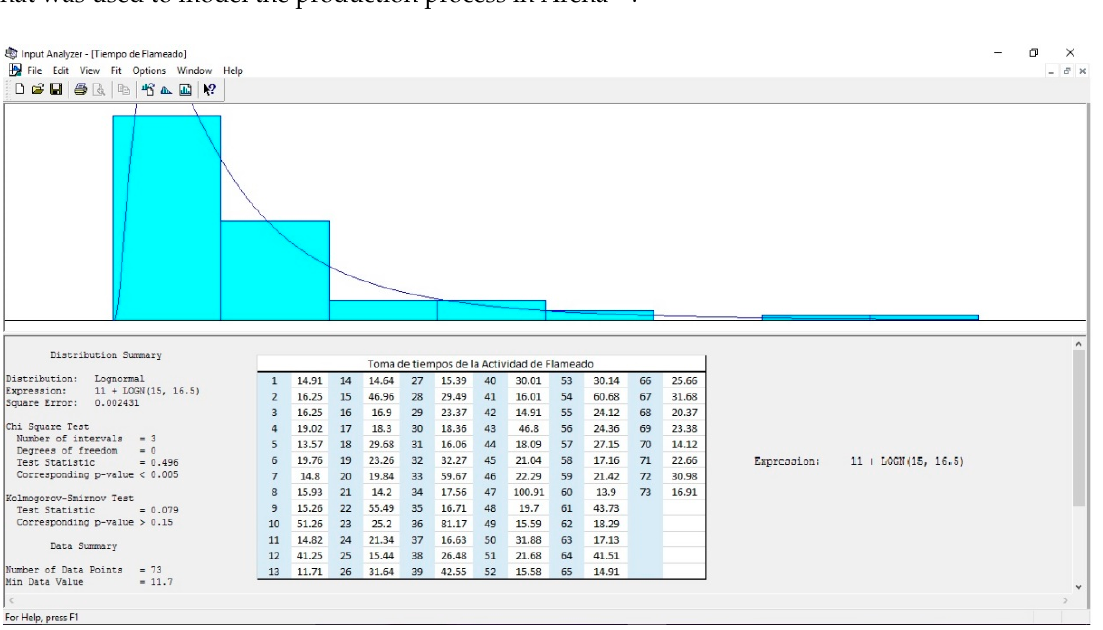
Table 2. Human resources by operation, elaborated by the author.